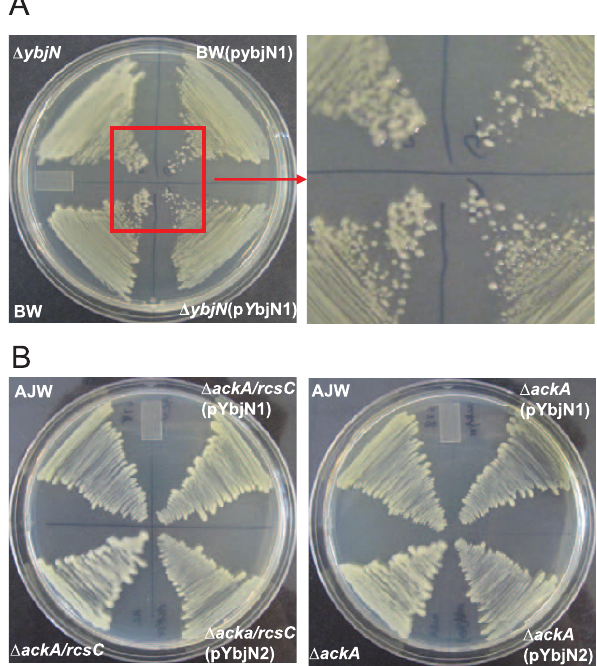
Figure 5. Impact of ybjN on capsule biosynthesis. A. ybjN negatively regulates colanic acid biosynthesis. Growth of E. coli strain BW25113 (BW), ybjN mutant and BW over-expressing ybjN on LB plates supplemented with 700 mM NaCl at 37 u C, showing mucoid phenotype of ybjN mutant. B. Over-expression of ybjN from both E. coli and E. amylovora suppresses mucoid phenotypes of E. coli strain AJW678, ackA and ackA/rcsC mutants. Bacteria were grown in LB for 24 h at 28 u C with shaking. 10 m l bacterial cells were streaked on LB plates supplemented with 700 mM NaCl and incubated at 28 u C as described previously [20]. Pictures were taken at 24